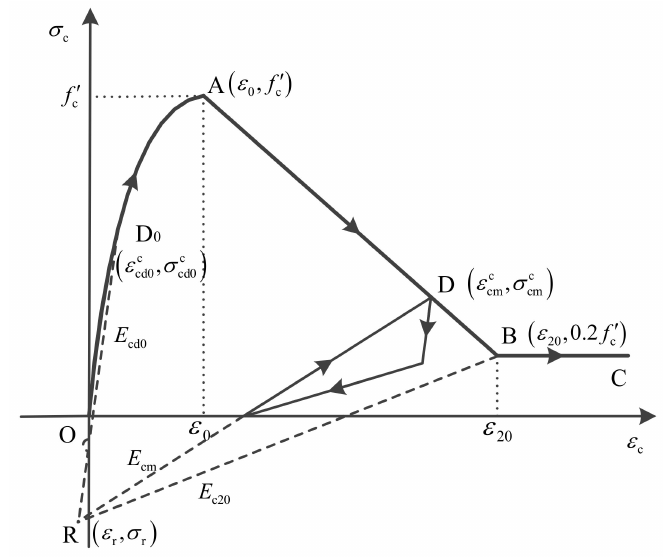
Figure 5. Yassin’s concrete constitutive